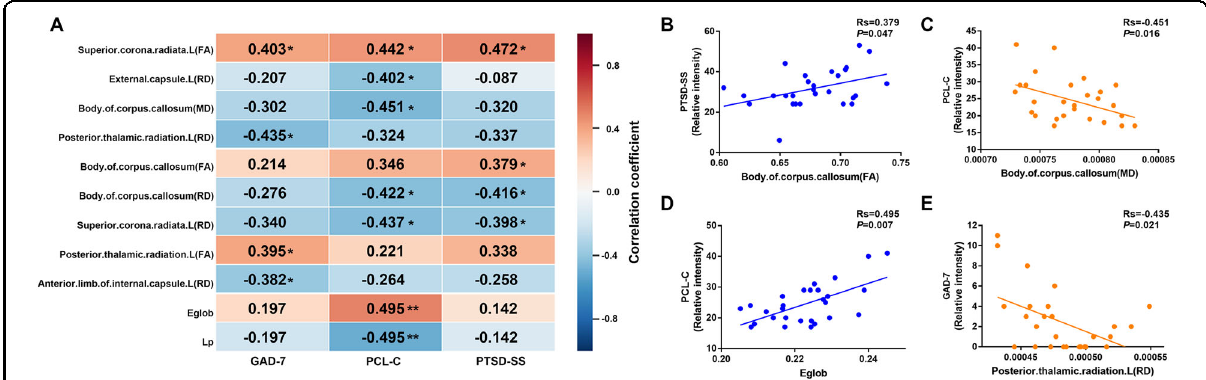
Fig. 2 Correlations between DTI network metrics, the various DTI-derived indices, and the mental health scores. A Correlations between DTI network metrics, the various DTI-derived indices, and the mental health scores in recovered COVID-19 patients. Each cell contains the correlation coef fi cient corresponding to the color scale. B Scatter plot of the body of corpus callosum (FA) and PTSD-SS score. C Scatter plot of the body of corpus callosum (MD) and PCL-C score. D Scatter plot of Eglob and PCL-C score. E Scatter plot of left posterior thalamic radiation (RD) and GAD-7 score. Eglob global ef fi ciency, Lp shortest path length, GAD-7 the Generalized Anxiety Disorder Screener GAD-7, PCL-C the PTSD checklist-civilian